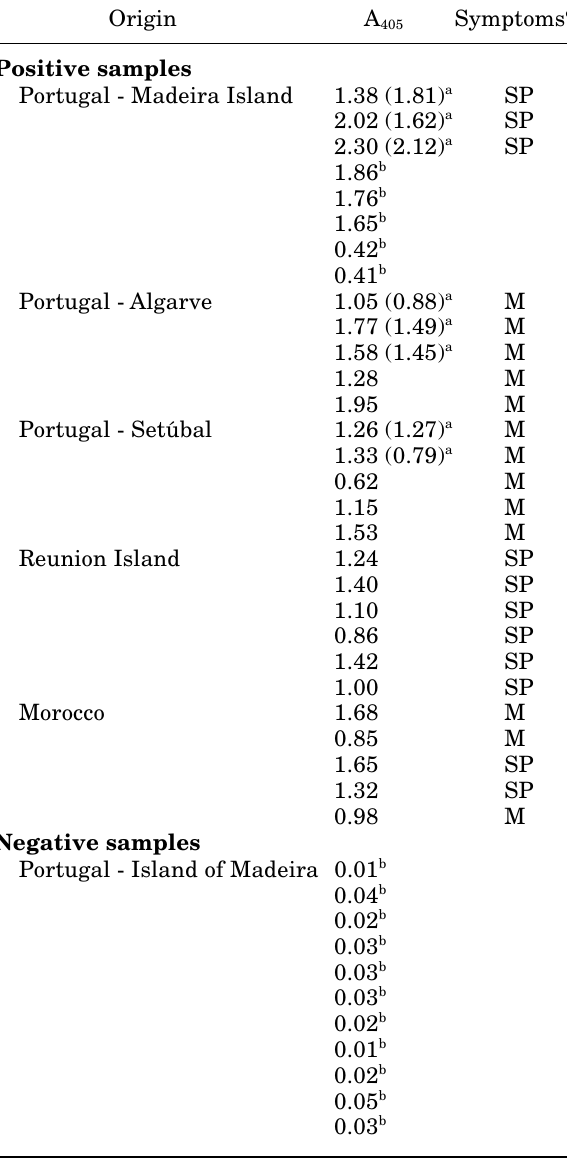
Table 1. ELISA values of samples from diverse origins maintained in collection or obtained in the field, tested with the biotinylated kit produced from the As 19-21